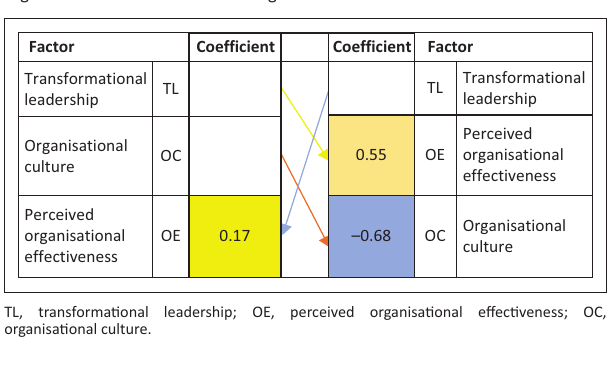
TABLE 8: Path analysis of the three variables.